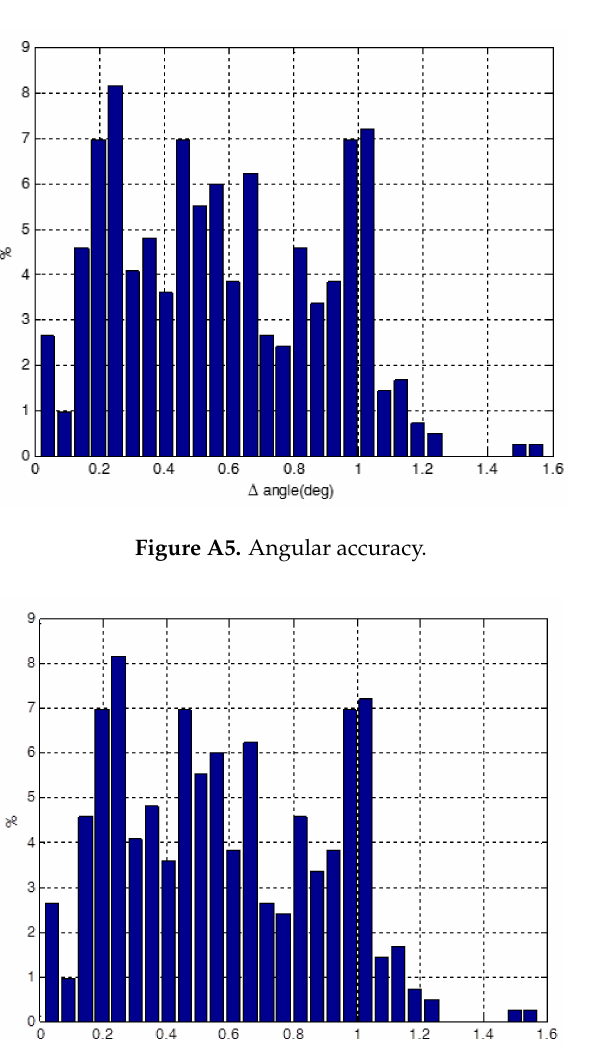
Figure A4. Range accuracy.